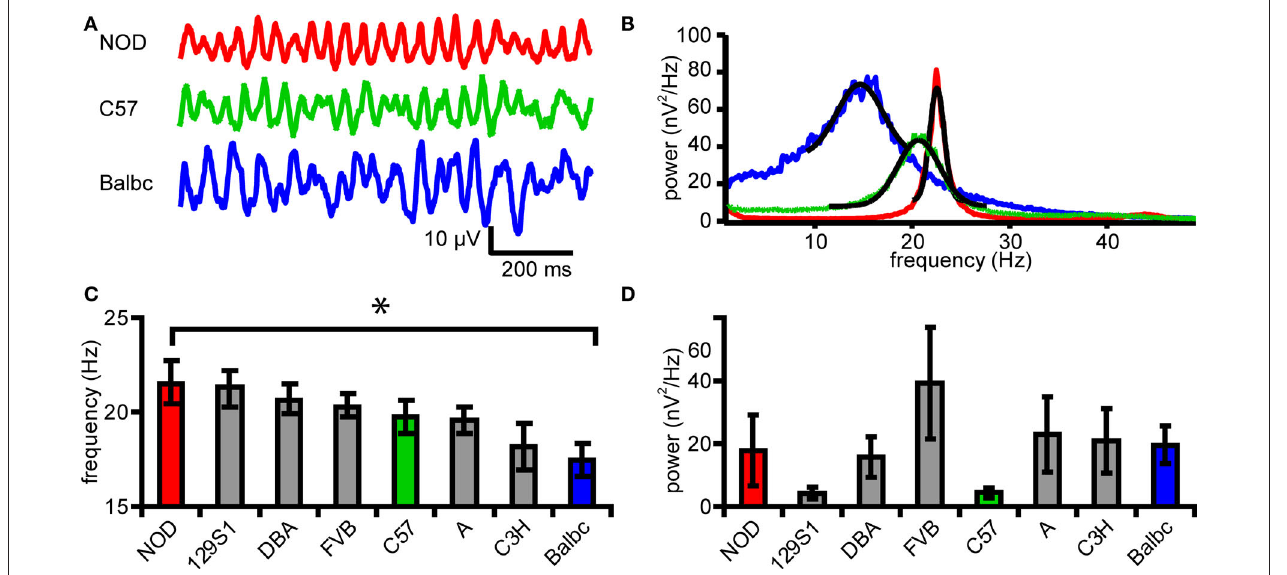
plot corresponding to the traces shown in B. Black lines show the Gaussian fits. (C) Peak frequency of oscillations in 8 different mouse strains. (D) Peak power of oscillations in 8 different mouse strains. Error bars show